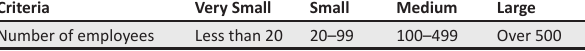
TABLE 5: Small Business Administration of the United States of America’s definition of small enterprises.